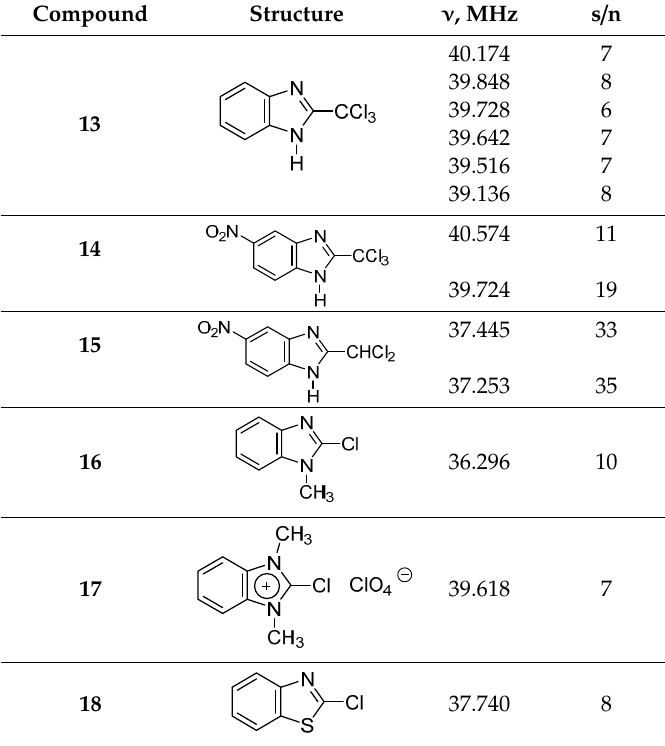
Table 2. The 35 Cl NQR frequencies at 77 K ( ν , MHz) and signal-to noise ratio (s / n) in the NQR spectra of chloro-containing benzimidazoles and benzothiazole ( 13 – 18 ).